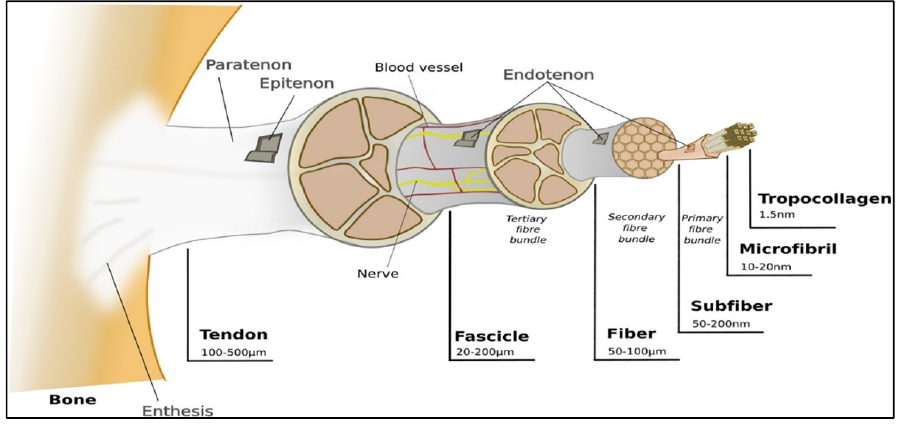
Figure 2. Representation of ligaments hierarchical structure. Reproduced with permission [3].